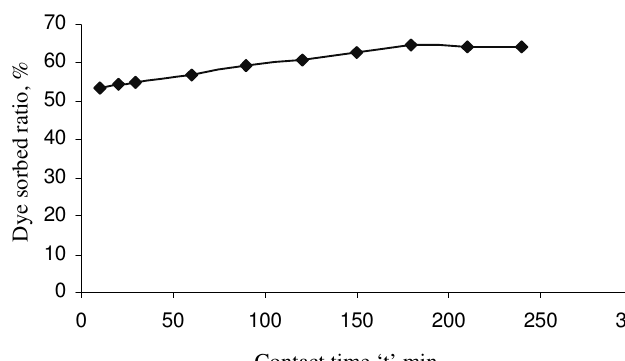
Figure 2 . Influence of dye concentration on adsorption of Grey BL by mango leaves (sorbent dose: 100 mg/L; particle size: 400 µ ; contact time: 5h; pH 7.0).